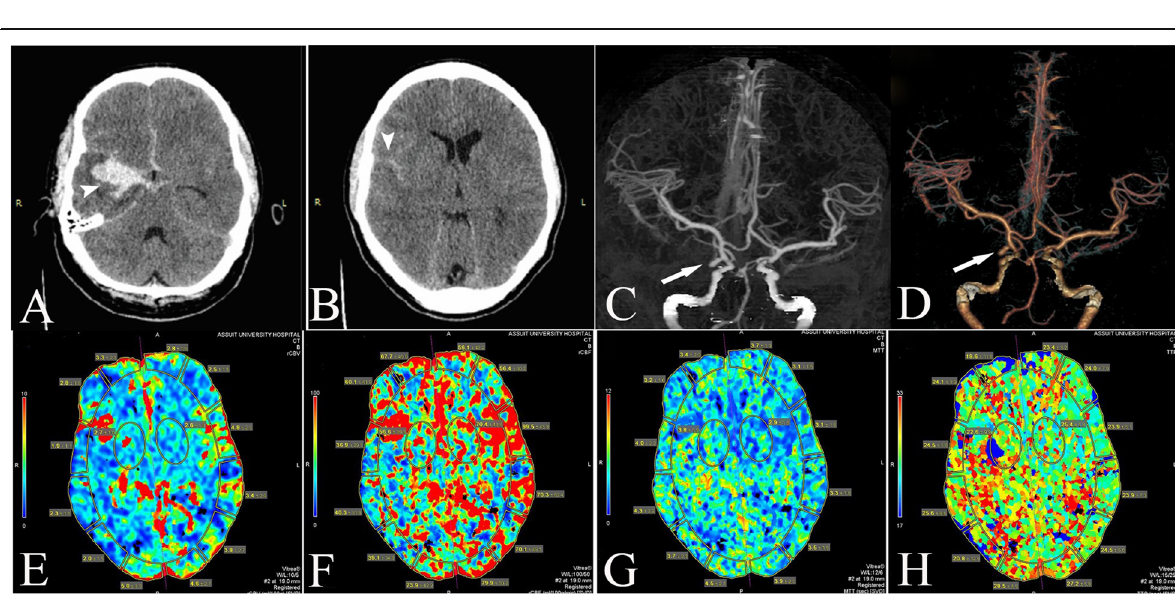
Fig. 3 A 36-year-old male patient presented with severe headache, neck stiffness, and mild left-sided hemiparesis. Non-contrast CT ( a , b ) shows right temporal hematoma and SAH within the right Sylvian and anterior interhemispheric fissures (asterisks in a and b ). MIP ( c ) and volume rendering ( d ) images of CTA show a saccular aneurysm at the right internal carotid artery; posterior communicating segment (arrowheads in c and d ). No vasospasm. CT perfusion maps show subtle perfusion deficit on the right-side following territory of right MCA; CBV ( e ), CBF ( f ), MTT ( g ), and TTP ( h